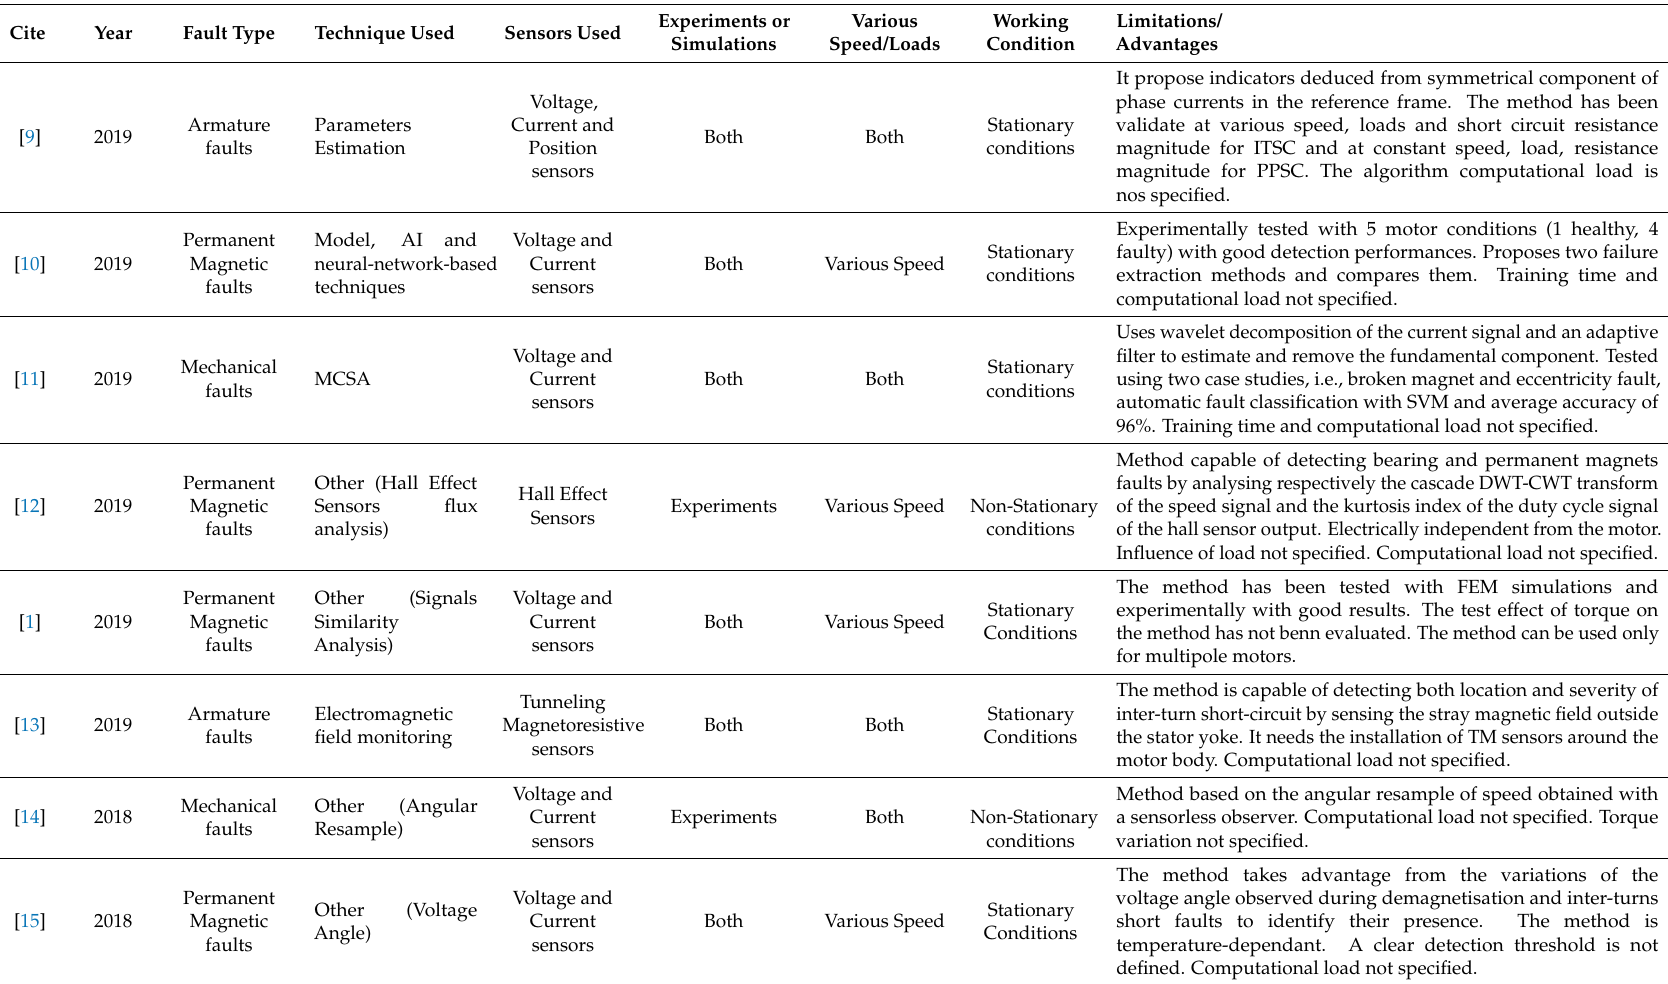
Table 1. Features table